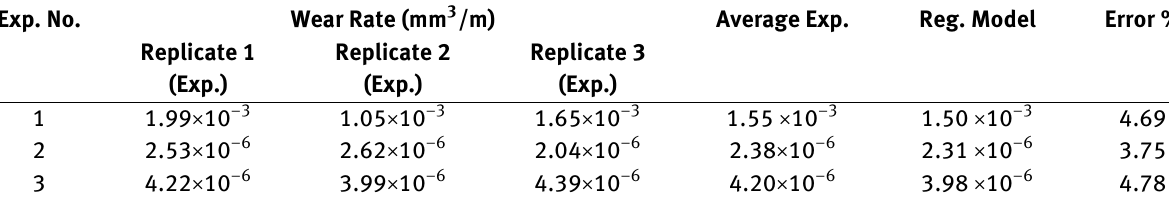
Table 11: Confirmation test results of experimental values along with regression values Exp.